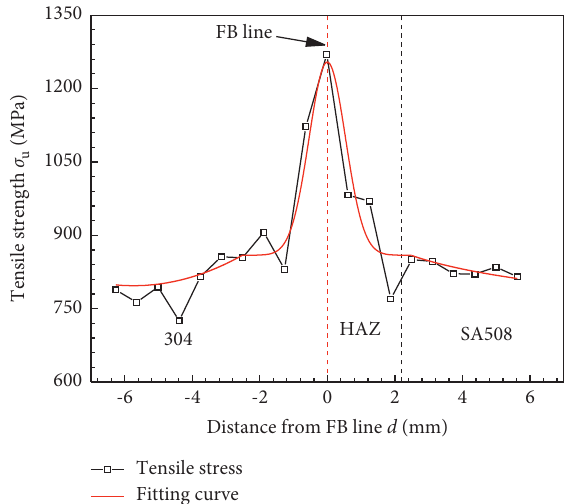
Figure 5: Local tensile strength σ u distribution of welded joints at different positions from FB